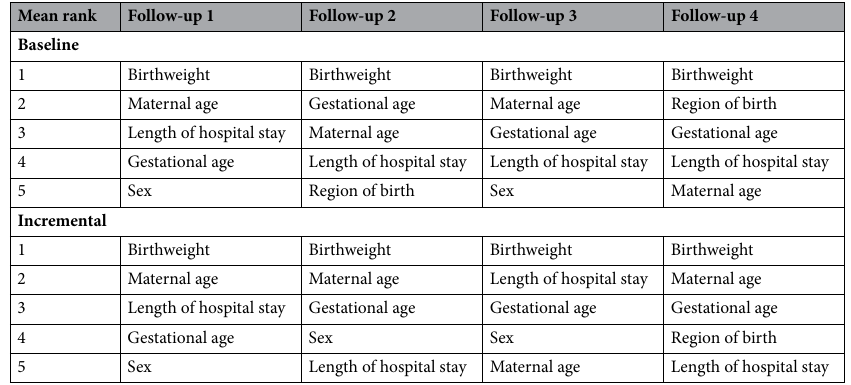
Table 3. The top- ranked variables by the variable importance for each year in Baseline and Incremental